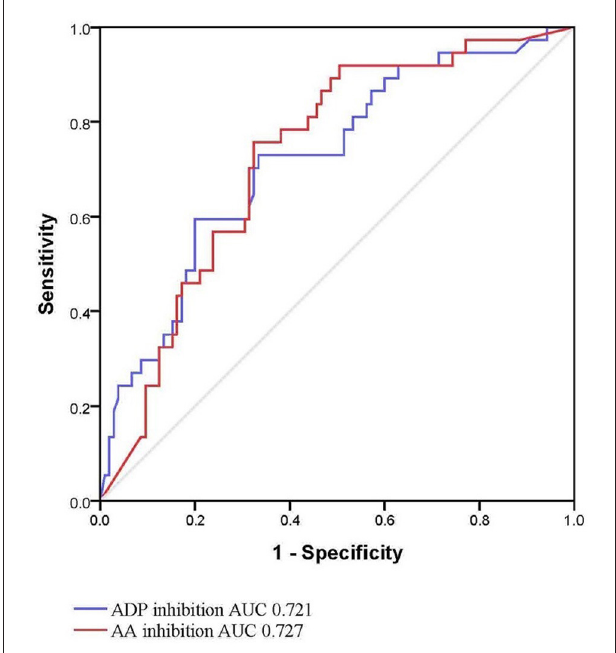
FIGURE 2 | Receiver operating characteristic curve for hematoma expansion with AA and ADP inhibition. AA, arachidonic acid; ADP, adenosine diphosphate; AUC, area under the